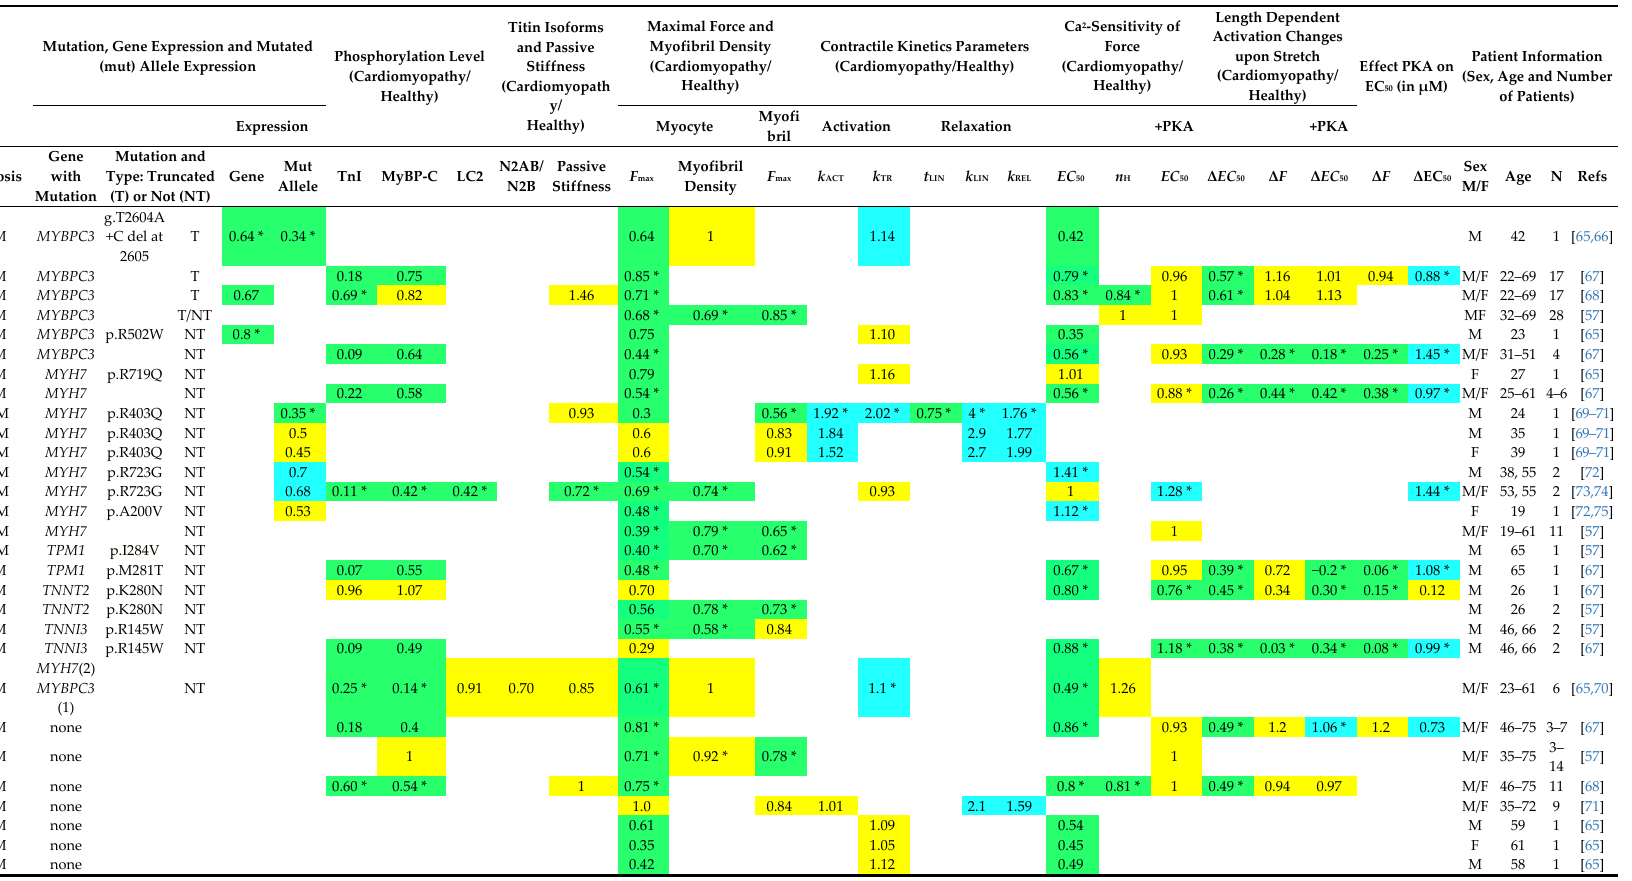
Table 1. Contractile characteristics of hypertrophic cardiomyopathy heart muscle.